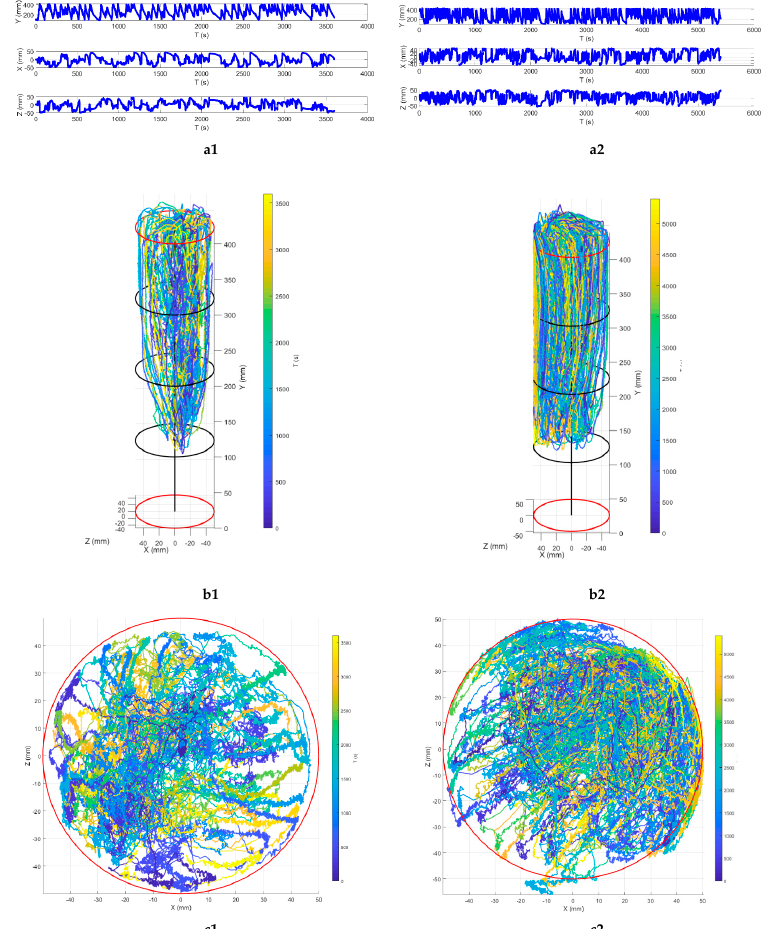
Figure A1. Trajectories of an activated quartz particle ( − 300 + 212 µm) inside the bed against time for 1.25 u mf (1) and 1.50 u mf (2): ( a ) the tracer trajectory with fit; the tracer trajectory from side view ( b ) and top view ( c ).